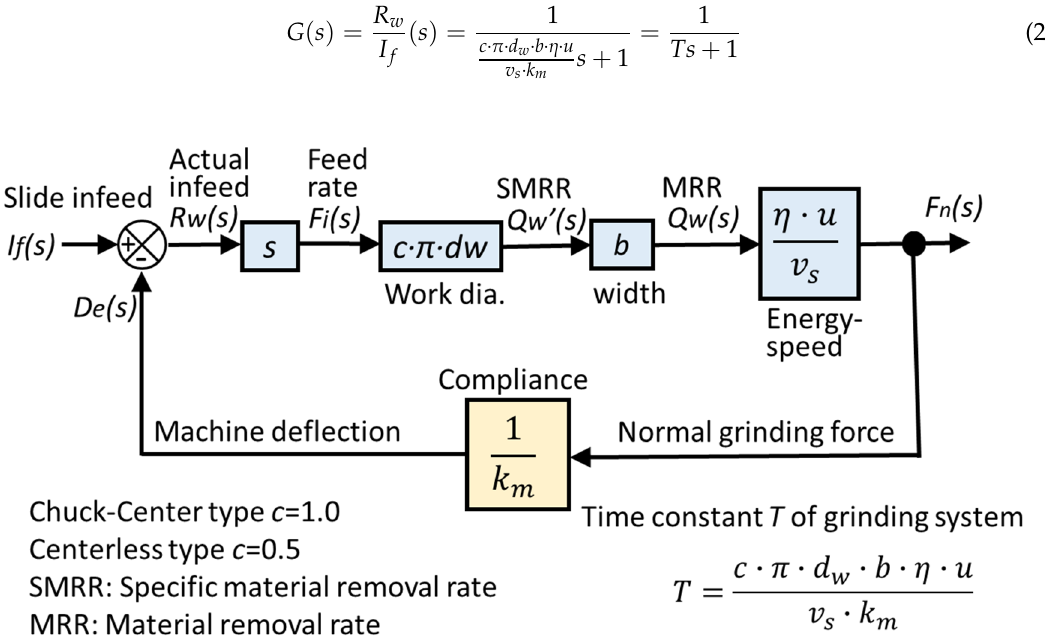
Figure 8. Block diagram of cylindrical grinding system.